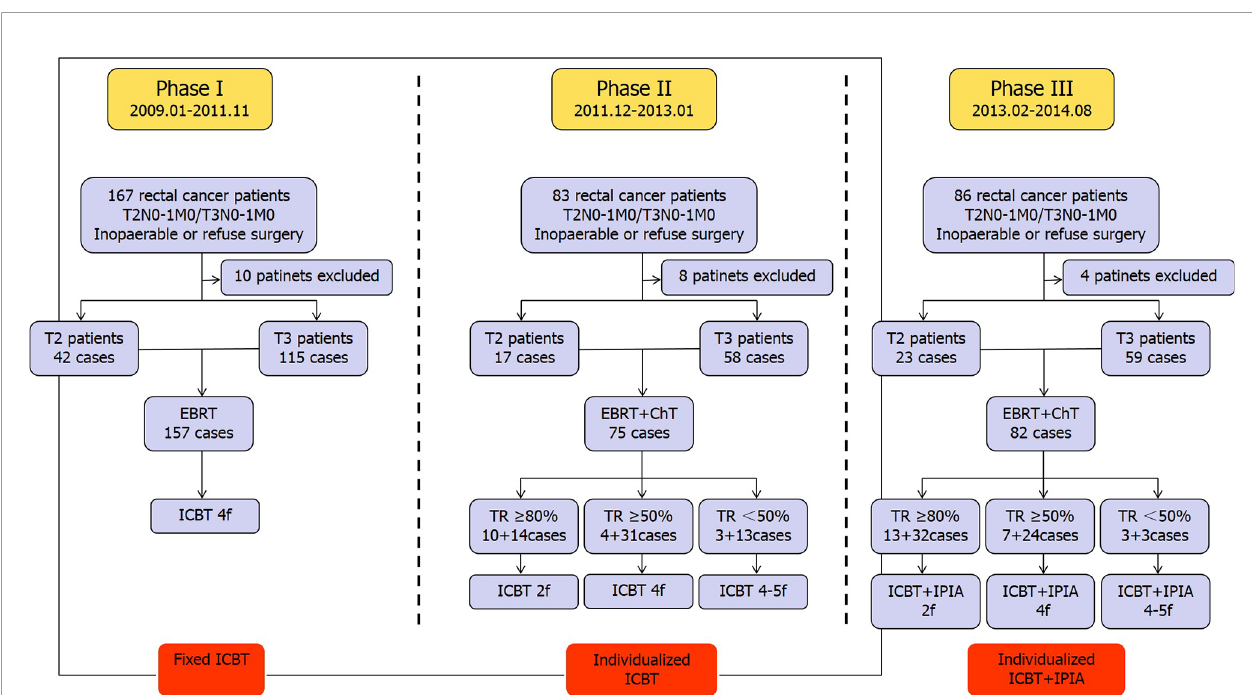
FIGURE 1 | Diagram for the three phases of current study. EBRT, external beam radiotherapy; ICBT, neutron intracavitary brachytherapy; ChT, chemotherapy; TR, tumor regression; IPIA, intrarectal peritumoral injection of amifostine; f,